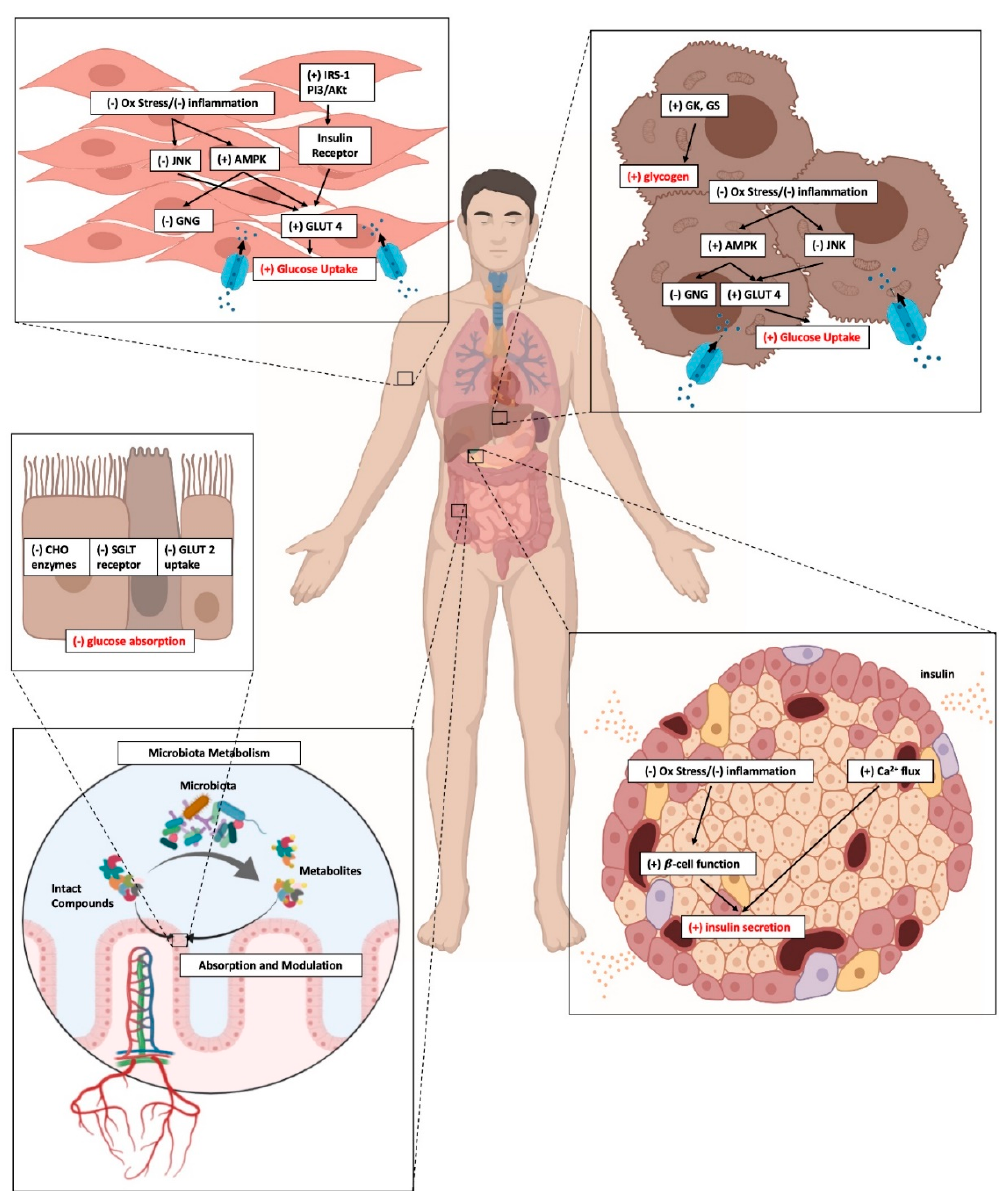
Figure 2. Cellular signaling pathways by which anthocyanin can modulate glucose homeostasis.